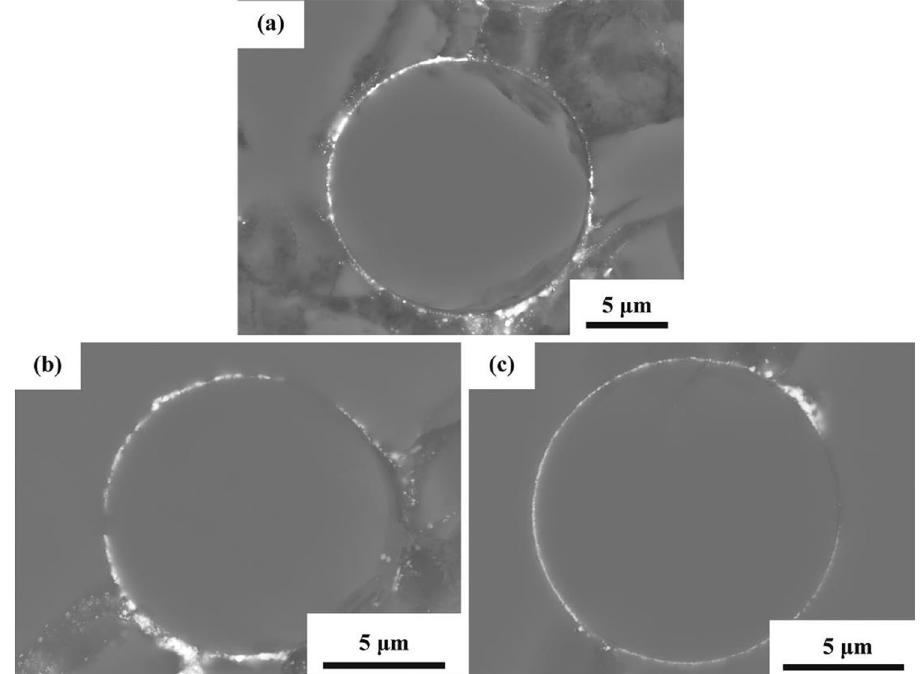
Figure 10. Cross-section view of SiC f /CaWO 4 /SiC minicomposites oxidized at ( a ) 1000 °C for 50 h, ( b ) 1100 °C for 10 h, and ( c ) 1100 °C for 50